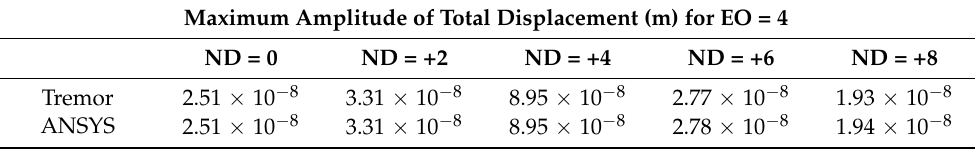
Table 2. Tremor–ANSYS comparison (1st family, out of resonance for EO = 4, case 3).